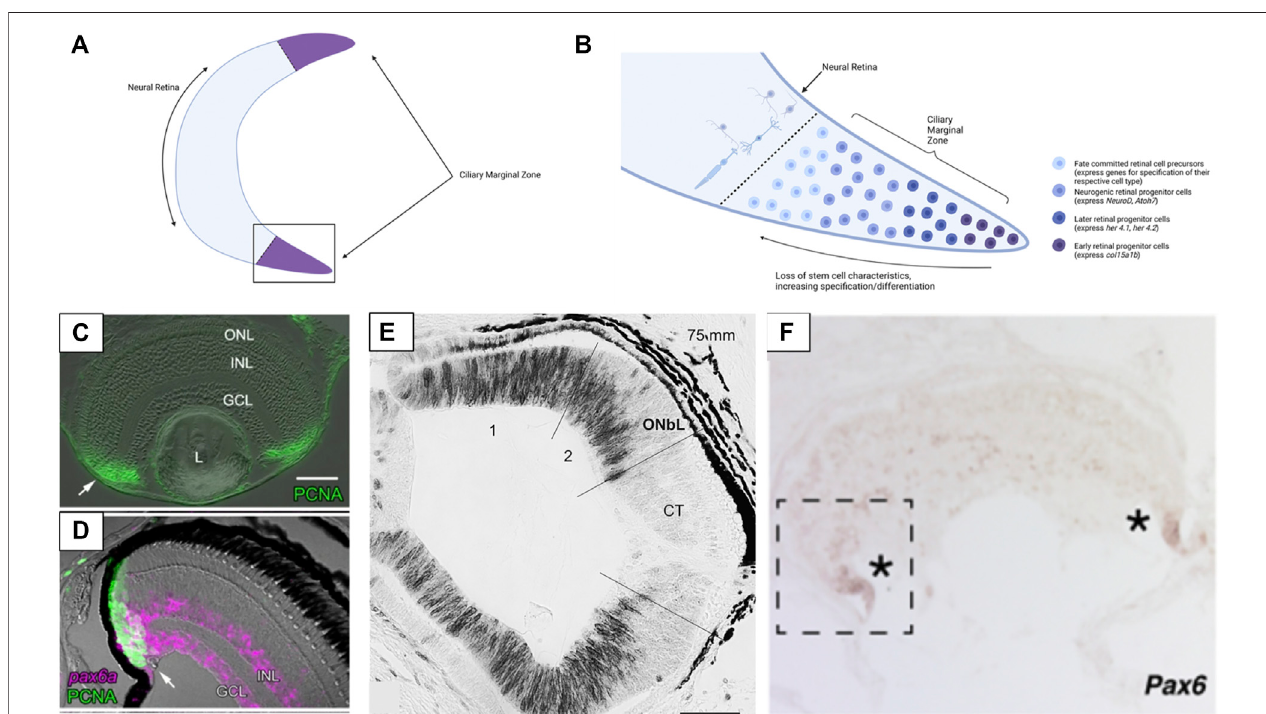
FIGURE 3 | Structure of the ciliary marginal zone (CMZ) in gnathostomes and cyclostomes. (A) The ciliary marginal zone is a proliferative region that occurs at the periphery of the neural retina in multiple vertebrate groups (though it is reduced/absent in mammals). (B) The boxed section of panel (A) . Within the ciliary marginal zone cellsclosesttotheperipheryaremultipotentstemcells(ingroupswithaproliferativeCMZ)thatdividetogeneratenewretinacells.Movingtowardsthecenteroftheretina thecellsoftheCMZbegintoexpressmarkersofneurogenesisandultimatelybecomespeci fi edanddifferentiatedasoneofthemainretinalcelltypes. (C) Presence of PCNA (a marker of proliferative cells) in the ciliary marginal zone of zebra fi sh. (D) In zebra fi sh Pax6 is expressed at the very peripheral margin of the CMZ (Pax6 marks theretinal stemcellsandasubsetofdifferentiated INL&GCLcells). (E) Inlamprey PCNA (black)labellingindicatesthatcellproliferationalso occursthroughout themore peripheral sections of the retina. Once lamprey reach complete metamorphosis the proliferative region of the retina loses PCNA expression (the CMZ-like tissue is not maintained into adulthood). (F) The hag fi sh retina has expression of Pax6 at the most peripheral margin. This is similar to Pax6 expression seen in the CMZ of other vertebrates and supports hag fi sh have a CMZ (or a CMZ-like tissue) at the margin of the retina. Panels (C, D) were adapted from Raymond et al. (2006) (Copyright © 2006,Raymondetal.;licenseeBioMedCentralLtd.).Panel (E) wasadaptedfromVillar-Chedaetal.(2008)(ReprintedfromBrainResearch,Volume1201,BegoñaVillar- Cheda, Xesús Manoel Abalo, Verona Villar-Cerviño,Antón Barreiro-Iglesias,Ramón Anadón,María Celina Rodicio,Late proliferation and photoreceptor differentiation in thetransforminglampreyretina,Page61,2008,withpermissionfromElsevier).Panel (F) wasadaptedfromDongandAllison,2021(Copyright © 2021,DongandAllison, 2021; The Royal Society (UK)). Graphics in Panels (A,B) were created using